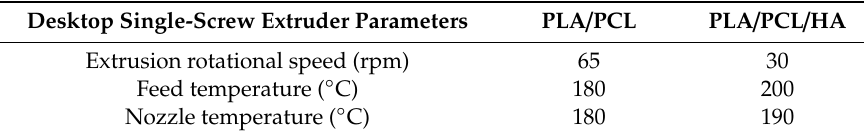
Table 2. Controlled extrusion parameters of the desktop single-screw